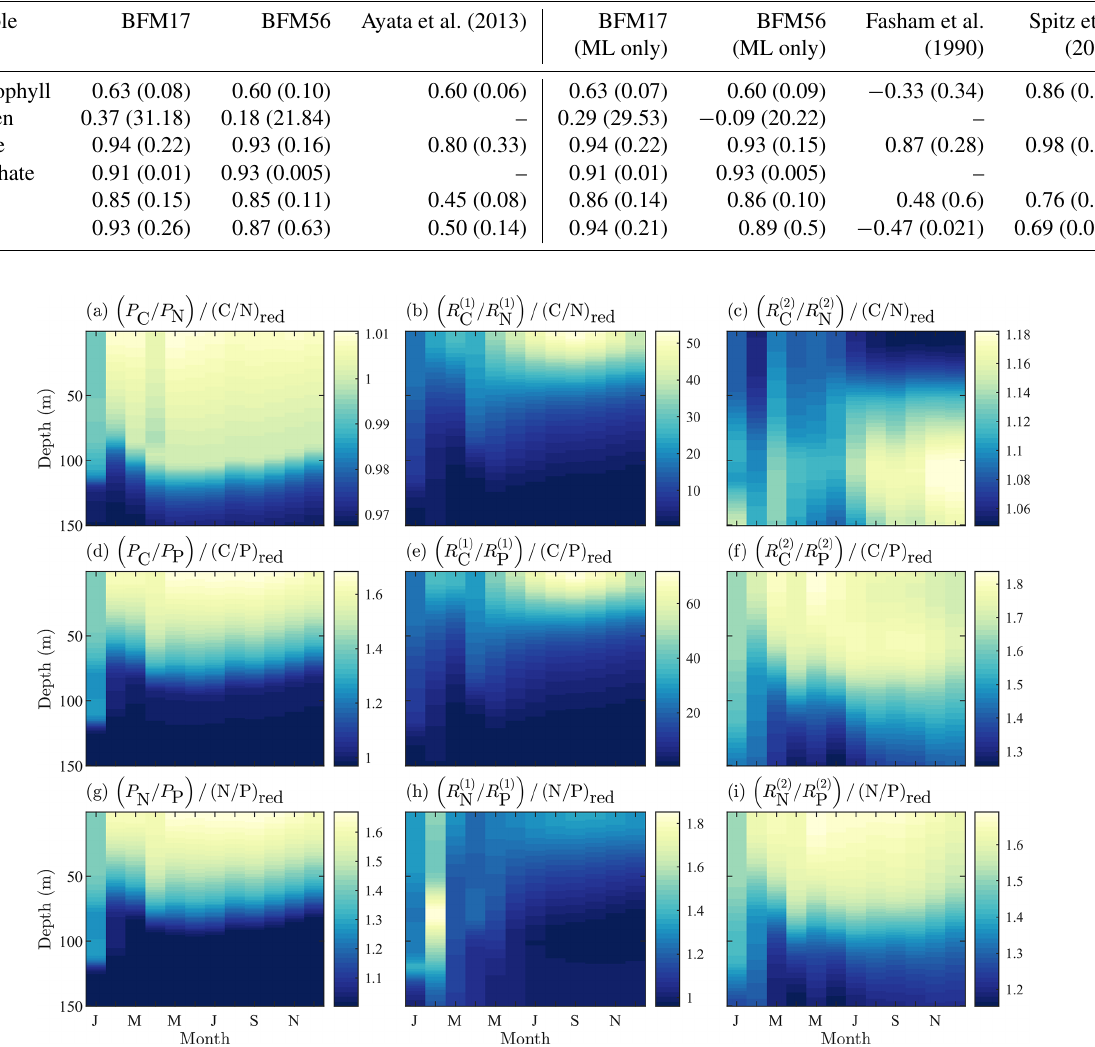
Figure 6. Fields of BFM17 constituent component ratios of carbon to nitrogen (a–c) , carbon to phosphorous (d–f) , and nitrogen to phospho- rous (g–i) for phytoplankton (a, d, g) , dissolved organic detritus (b, e, h) , and particulate organic detritus (c, f, i) . Each field is normalized by the respective Redfield